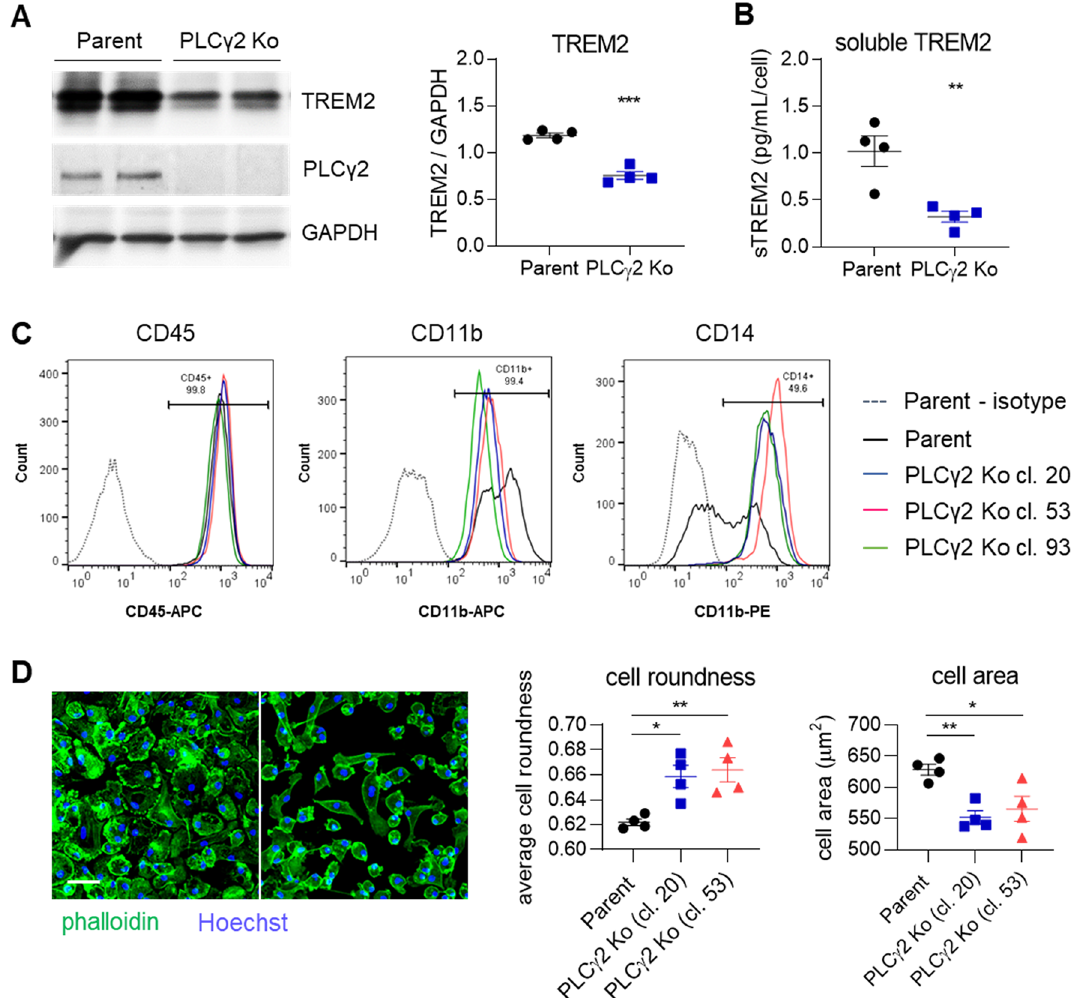
Figure 2. PLCγ2 Ko leads to dysregulation of cell surface marker expression and morphological changes in iPSC-derived macrophages. ( A ) Western blot confirms lack of PLCγ2 protein in PLCγ2 Ko and shows reduction in TREM2 expression in PLCγ2 KO macrophages compared to Parent. n = 4. Full immunoblot images are presented in Supplementary Fig. 7. ( B ) Levels of soluble TREM2 detected in cell supernatant 8 days after plating are lower in PLCγ2 Ko cells compared to Parent. n = 4, ( C ) Macrophage surface markers CD11b, CD14, and CD45 were measured by flow cytometry, compared to relevant isotype IgG. Annotations indicate frequency of marker positivity in the Parent line. ( D) Morphology of macrophage lines was determined by phalloidin staining and analysis of cell roundness and cell area. Scale bar 50 μm. n = 4, data shown represent mean ± SEM, One-way ANOVA followed by Bonferroni’s multiple comparison test. * p < 0.05, ** p <